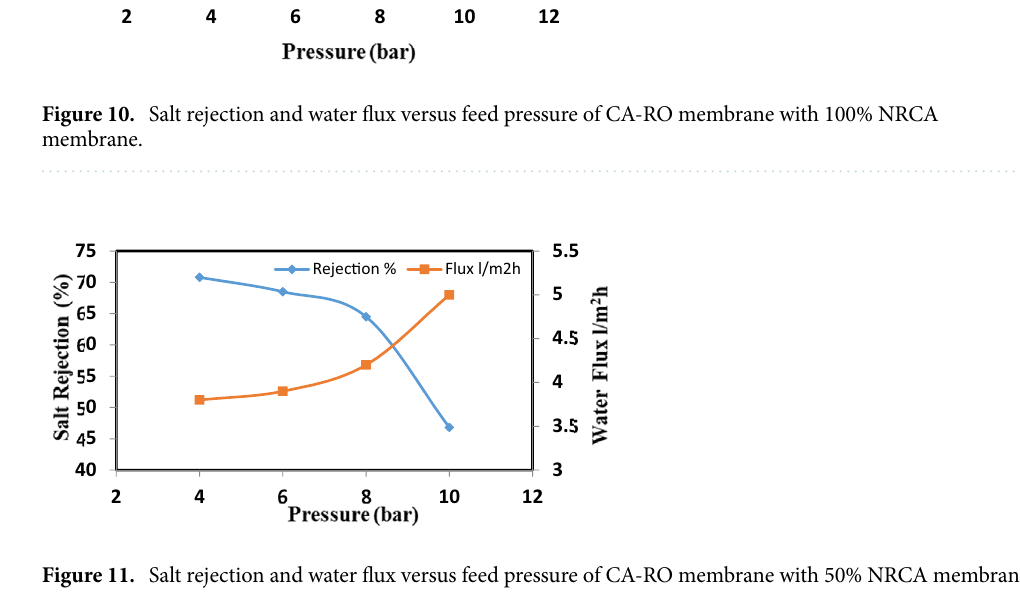
Figure 11. Salt rejection and water flux versus feed pressure of CA-RO membrane with 50% NRCA membrane.